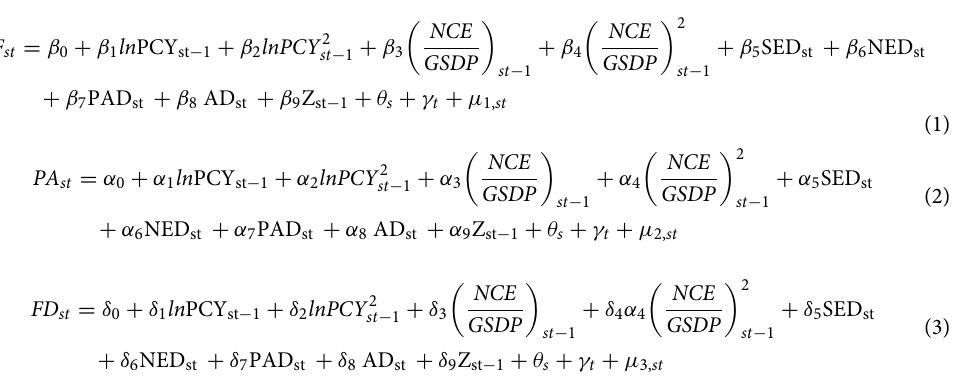
where s represents State {1….19} and t represents the year {1980…2011}, FF st denote fatalities in state s and year t , PA st indicates population affected due to floods, and FD st denotes natural logarithm of the ratio of flood dam- age over Gross State Domestic Product (GSDP); ln PCY st − 1 is the natural logarithm of lag of per capita income (PCI), lnPCY 2 st − 1 denotes the squared natural logarithm of per capita income (PCI) that captures the non-line- arities between income and flood fatalities. This implies β 1 > 0 and β 2 < 0 , revealing an inverted U-shaped relationship between flood fatalities and ln PCY it − 1 . In Eq. (1) the turning point of PCI where flood fatalities (FF) − β 1 NCE = β 1 + 2 β 2 lnPCI it − 1 = 0, turning point ( τ ) = exp . are at a maximum, is given by: ∂ FF it ∂ lnPCI 2 β 2 GSDP st − 1 it − 1 2 (cid:31) (cid:30) NCE (cid:30) (cid:31) is the lag of the ratio of natural calamity expenditure (NCE) over GSDP and is the squared lag of the GSDP st − 1 ratio of natural calamity expenditure (NCE) over GSDP. These two variables capture the non-linear relationship (cid:30) (cid:31) between natural calamity expenditure and flood fatalities. In Eq. (1), β 3 > 0 and β 4 < 0 reveal an inverted U-shaped relationship between flood fatalities and natural calamity expenditure (NCE). The turning point of natural calamity expenditure where flood fatalities (FF) are at the maximum is given by − β 3 ∂ FF it = β 3 + 2 β 4 = 0, turning point ( τ ) = . 2 β 4 st − 1 NCE ∂ (cid:31) (cid:30) GSDP (cid:30) st − 1 (cid:29) (cid:28) (cid:31) In Eq. (2), α 1 > 0 and α 2 < 0 reveal an inverted U-shaped relationship between the population affected and − α 1 PCI. The turning point of PCI at which the population affected is maximum is given by ( τ ) = exp . In 2 α 2 (cid:31) (cid:30) addition, α 3 > 0 and α 4 < 0 represent the inverted U-shaped relationship between the population affected and NCE. In other words, the turning point of NCE where the population affected are at the maximum, is given by − α 3 ( τ ) = . In Eq. (3), δ 1 > 0 and δ 2 < 0 show the inverted U-shaped relationship between flood damages 2 α 4 (cid:31) (cid:30) − δ 1 and PCI. The turning point of PCI at which flood damages are at the maximum, is given by ( τ ) = exp . 2 δ 2 (cid:31) (cid:30) Moreover, δ 3 > 0 and δ 4 < 0 , which reveals an inverted U-shaped relationship between flood damages and NCE. − δ 3 The turning point of NCE at which flood damages are at the maximum, is given by ( τ ) = exp . 2 δ 4 (cid:31) (cid:30) SED st is the state election dummy equal to 1 for the years in which elections are held in a State; otherwise, it is zero. NED st is the national election dummy, which is equal to 1 for the years in which elections are held at the national-level; otherwise, it is zero. PAD st takes on a value of 1 if the State and Centre have the same politi- cal party in power; otherwise, it is zero. The flood-affected area dummies (AD) are created by categorizing the state-wise flood-affected area into four categories. This helps control flood magnitude in the empirical analysis. For a detailed discussion, see the section on ‘Data sources.’ The variable of interest is economic development (proxied by the lag of PCI and squared lag of PCI). The other variable of interest is the lag of government responsiveness and the squared lag of government responsiveness (proxied by natural calamities expenditure as % of GSDP). The control variables ( Z st − 1 ) are common to all three econometric specifications. These variables include proxies for coping strategies, such as financial development (measured as total credit outstanding as a percentage of GSDP), forest cover (measured as log of forest cover/ total state area), and flood control and prevention expenditure measures. The other control variables include rural head count ratio: the number of rural people living below the poverty line (as a percentage of rural popu- lation), population density, the severity of floods, an election year, and political alignment. We have used the 1-year lagged values of the explanatory variables to control for potential endogeneity issues. θ s is time-invariant state-specific fixed effects whereas γ t captures time-specific heterogeneity. µ st is a normally distributed error term. The outcome variables are flood fatalities and population affected in Eqs. (1) and (2), respectively. Flood fatalities and population affected are measured as the number of people who were killed and affected due to floods in different states in the respective years. Both the outcome variables are non-negative count variables. As shown in Appendix Table A.1, the variances of the two variables exceed their respective means implying that flood fatalities and population affected variables are overdispersed. This violates the normality assumption of the Ordinary Least Squares (OLS) model. In this particular case, the OLS method of estimation yields biased results. Therefore, using FE Poisson and Negative Binomial models is more appropriate to estimate Eqs. (1) and (2). In particular, the overdispersion of dependent variables violates the fundamental assumption of the FE